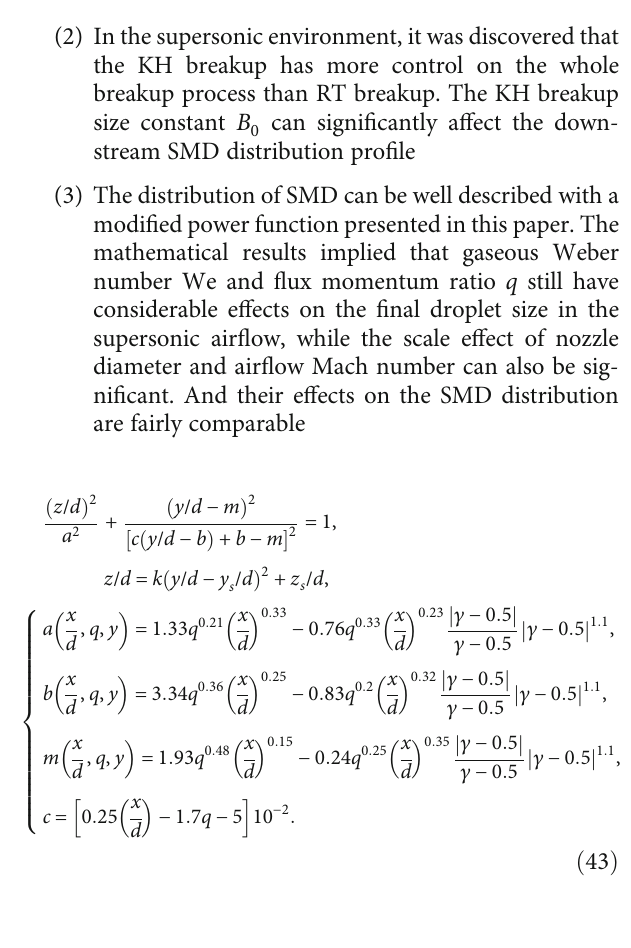
Figure 22: Schematic diagram of multivariate nonlinear fi